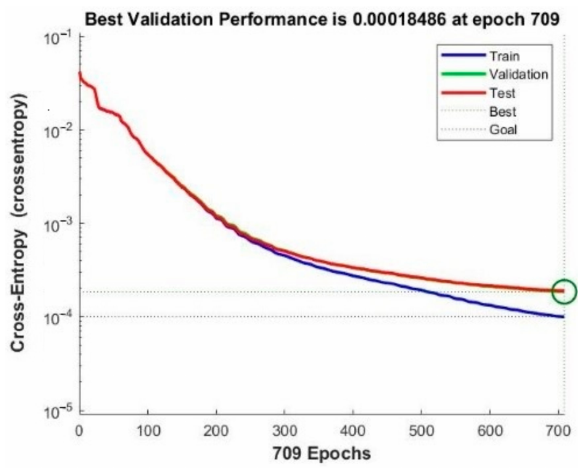
Figure 17. Model performance